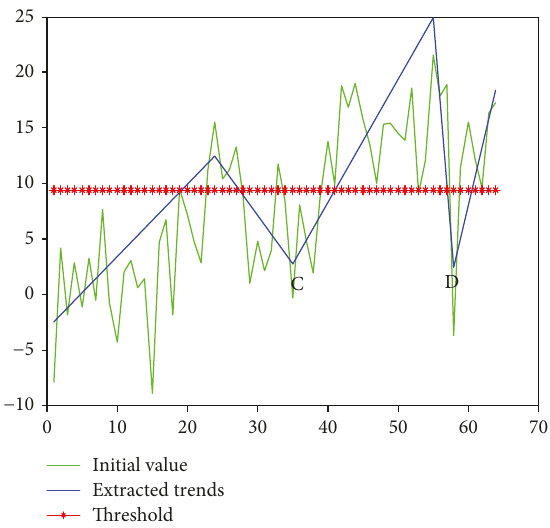
Figure 10: Initial value and extracted trends of T